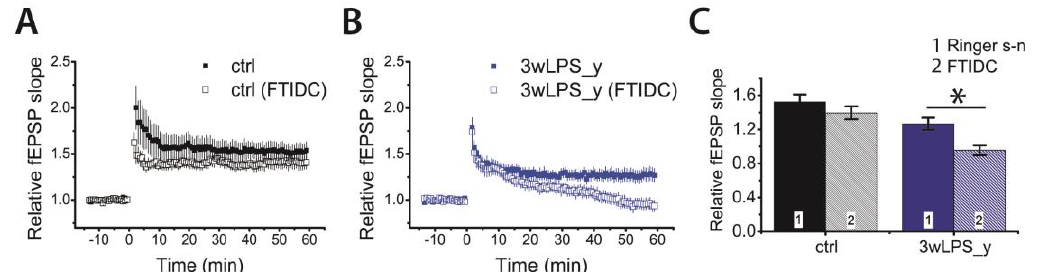
Figure 6. Metabotropic glutamate receptor (mGluR)-dependent form of LTP presents in the hippocampal CA1 area of juvenile rats administered with LPS during the third postnatal week. Diagrams showing the normalized slope of fEPSP in the control ( A ) and experimental ( B ) groups. Note that FTIDC (4-[1-(2-fluoropyridin-3-yl)-5-methyltriazol-4-yl]-N-methylN-propan-2-yl-3,6dihydro-2H-pyridine-1-carboxamide) (5 μM) affected LTP only in the 3wLPS_y group. ( C ) Diagram illustrating the effect of FTIDS on LTP values in different groups of rats, respectively * p < 0.05 ( t -test).